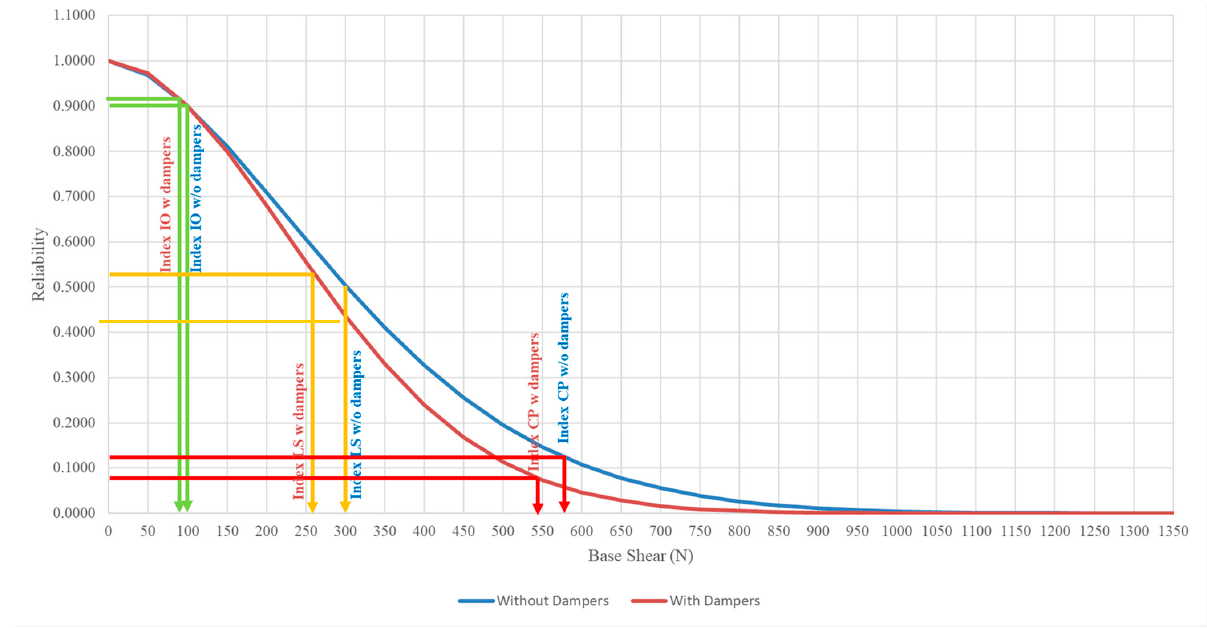
Figure 14. Reliability plot for structures with and without dampers attached on the second storey.